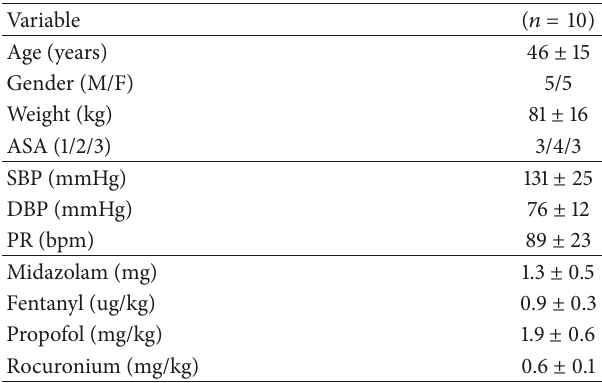
Table 1: Demographics, baseline hemodynamic values, and induc- tion